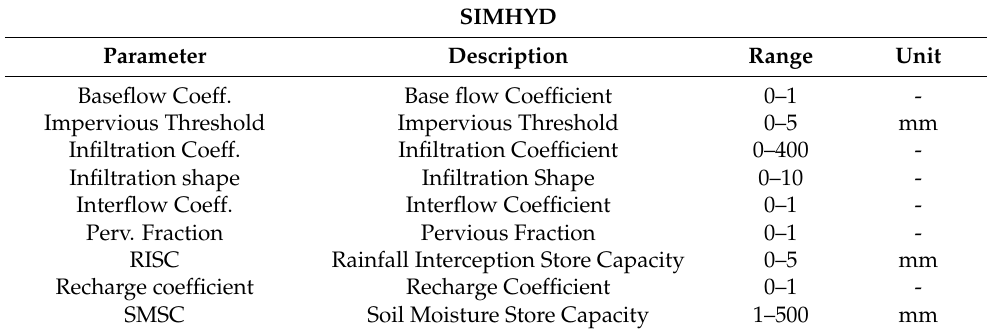
Table 4. Parameters of the SIMHYD model and their